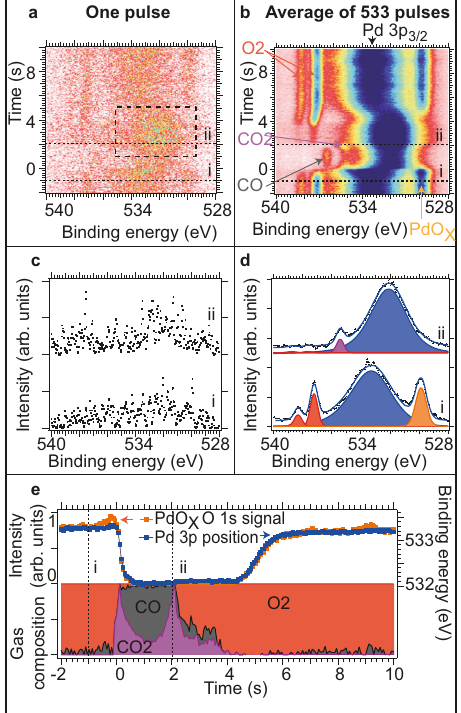
Fig. 2 Analysis of time-resolved O 1s data recorded at 100 mbar before and after event-averaging. a , b Image plots of time-resolved O 1s data acquired with 17 Hz and a photon energy of 4.6 keV before and after event- averaging 533 pulses. c , d Single spectra recorded along the dotted lines i and ii in panels ( a , b ) including curve fi tting for the event-averaged spectra. Components are de fi ned in panel ( b ). e Relative gas composition, PdO x O 1s intensity signal, and binding energy position of Pd 3p 3/2 peak as obtained by curve fi tting all spectra in panel ( b ). Relative gas composition is shown on vertically stacked y -axises. The following colours and markers are used in panels ( d , e ): O 2 (g) red, CO(g) grey, CO 2 (g) purple, Pd 3p 3/2 binding energy position blue squares, and PdO x oxide intensity orange